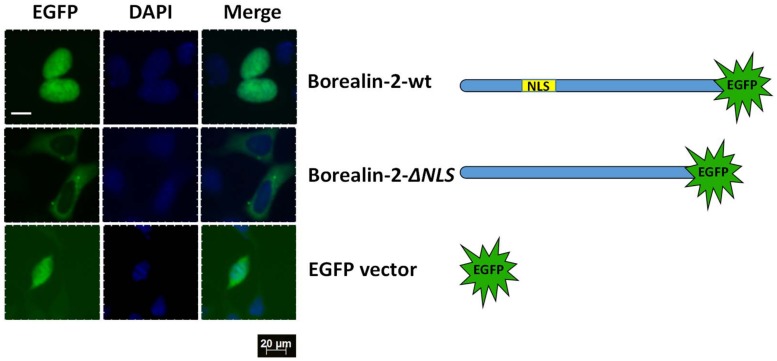
GFP reporter assay showing nuclear localization of Borealin-2 protein.HEK293 cells were transfected with GFP reporter constructs expressing either an EGFP-tagged wild type Borealin-2 (Borealin-2-wt) or a mutant Borealin-2 with its NLS deleted (Borealin-2-ΔNLS). Empty pcDNA3-EGFP vector was used as a control. Nuclear DNA was stained with DAPI and cells were analyzed with a fluorescence microscope. Scale bars, 20 μm.